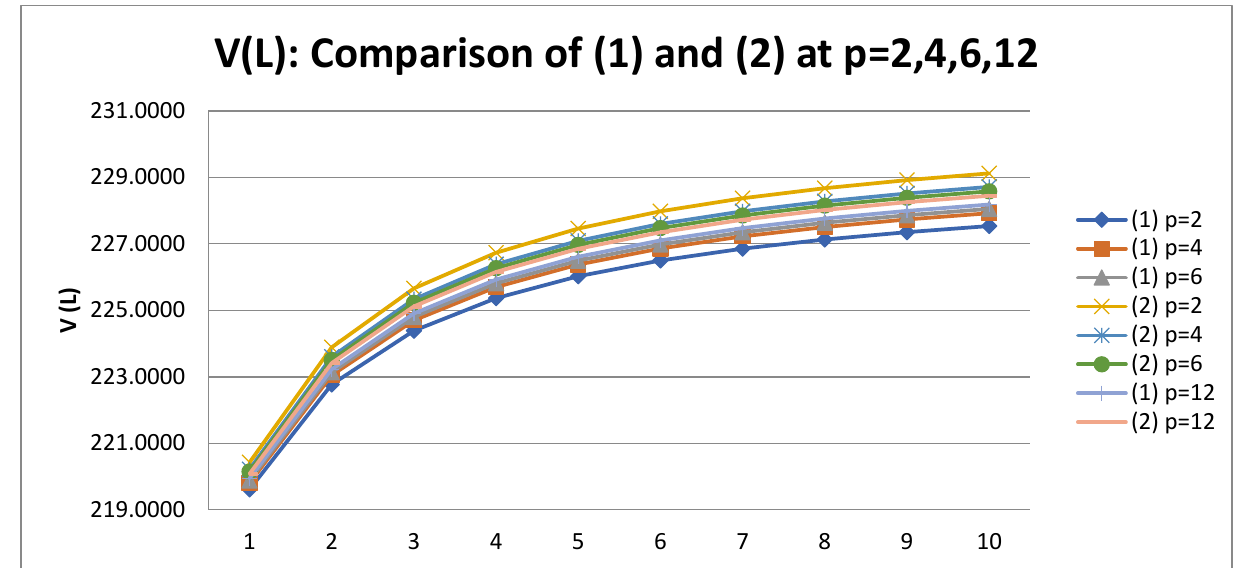
Figure 5. The comparison of the dependence of the company value (V) on the leverage level (L) of a three-year-old company for profit tax payments that were (1) made at the end of the financial period and (2) made at the beginning of the financial period (i.e., advance payments) with frequencies of p = 2, 4, 6 and 12 is shown in Figure 4.